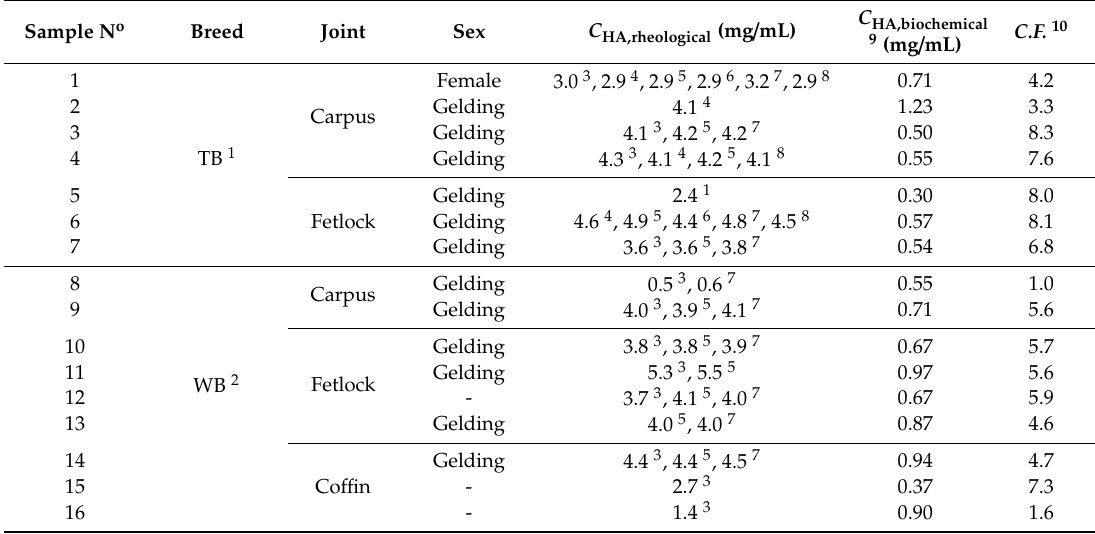
Table A1. Calculated HA concentration in healthy equine SF samples based on SF rheology and on the biochemical ELISA method.